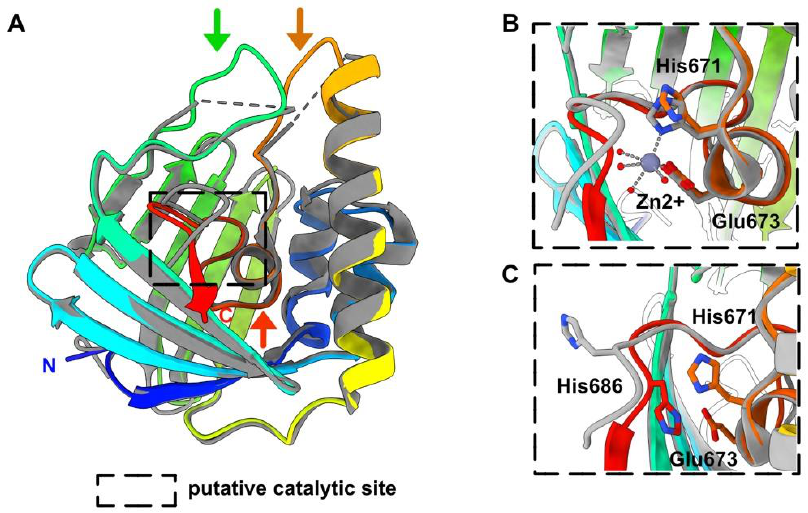
Figure 3. HEV-3 nsP2 predicted structure, a metal binding protein. ( A ) Ribbon representation of the HEV-3 nsP2 predicted structure (rainbow colored), superimposed to the HEV-1 nsP2 crystal structure (in grey) [33]. The green and orange arrows indicate the position of loops predicted by AF2 and not visible in the HEV-1 nsP2 crystal structure. The red arrow points to the position of the pre-C-terminal helix that would sit in the putative fatty acid-binding cavity in both nsP2 structures. ( B , C ). Insets on the putative catalytic site showing the Zn 2+ ion, its coordinating residues His 671 and Glu 673, and the His 686 that move towards the center of the protein in the HEV-3 nsP2 predicted structure.